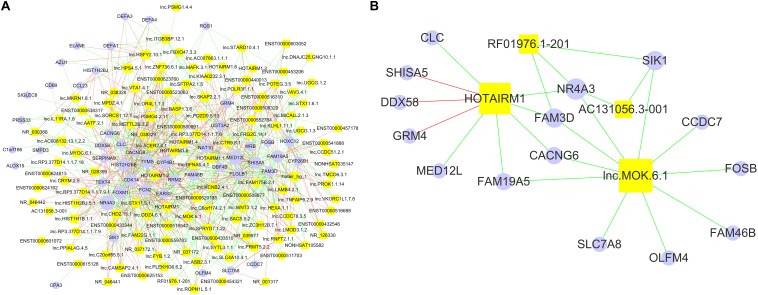
The network of significantly correlated DE lncRNAs and mRNAs. (A) The positive correlations among 122 DE lncRNAs (yellow squares) and 48 DE mRNAs (purple closed circles) are represented by red lines, and the negative correlations were represented by green lines. The number of correlations between a specific lncRNA or mRNA and others are represented by the size of the yellow squares and purple closed circles, respectively. (B) The network of lncRNAs AC131056.3-001, HOTAIRM1, lnc-MOK-6:1, and RF01976.1-201 and their correlated mRNAs. Non-parametric Spearman correlation analysis was performed. The criteria of p < 0.05 and r ≥ 0.8 were used to define the positive correlations; and p > 0.05 and r ≤ −0.8 for negative correlations.